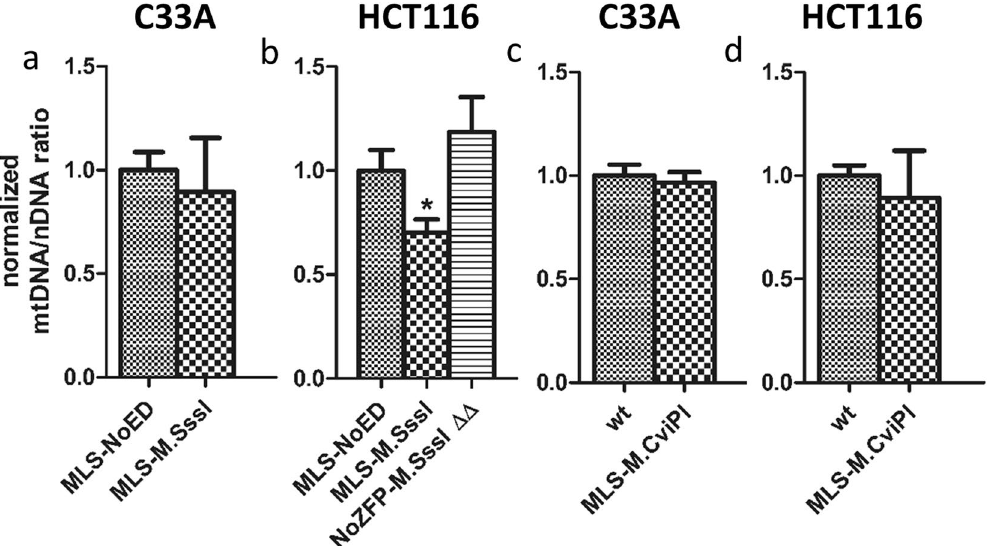
Figure 6. Normalised mitochondrial DNA copy number of cells expressing mitochondria-targeted M.SssI, the catalytically inactive double mutant of M.SssI, or M.CviPI. The effect of mitochondria-targeted M.SssI (MLS-M.SssI) or the catalytically inactive double mutant of M.SssI (MLS-M.SssI ∆∆ , only for HCT116 cells) on mitochondrial DNA copy number normalised to empty vector control (MLS-NoED) was determined in stable cell lines of C33A ( a ) or HCT116 ( b ). Similarly, the effect of mitochondria-targeted M.CviPI (MLS-M. CvPI) on mitochondrial DNA copy number normalised to wild-type control (wt) was determined in stable cell lines of C33A ( c ) or HCT116 ( d ). Each data point represents the mean ± SEM of at least three independent experiments.